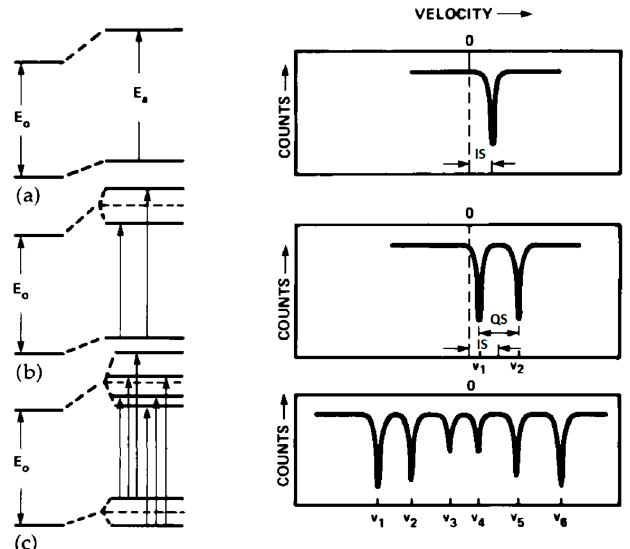
Figure 9. The three main types of hyperfine interactions between electrons and nucleus of Fe 57 in solids: ( a ) electrostatic interaction gives rise to isomer shift (IS); ( b ) the asymmetry in the distribution of electrical charge at the core produces a quadrupole splitting (QS); and ( c ) the magnetic interaction divides the spectrum into six lines (a quadrupole interaction is also present). Reproduced from [28], with permission from AIP Publishing, 1939.